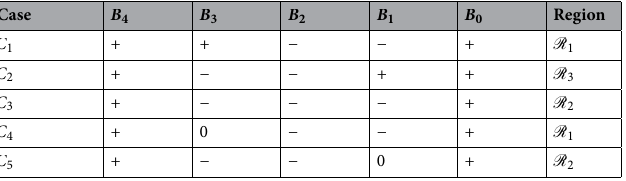
Table 1. Admissible cases given by the method of Descartes applied to the polynomial g assuming that its coefficients B i with i ∈ { 0, 1, 2, 3, 4 } take the values according to ( A 1 , A 2 , A 3 ) ∈ ( 0, 1 ) 3 . Each row corresponds to the case in which the signs of the coefficients of g are as indicated depending on the region R j with j ∈ { 1, 2, 3 } .